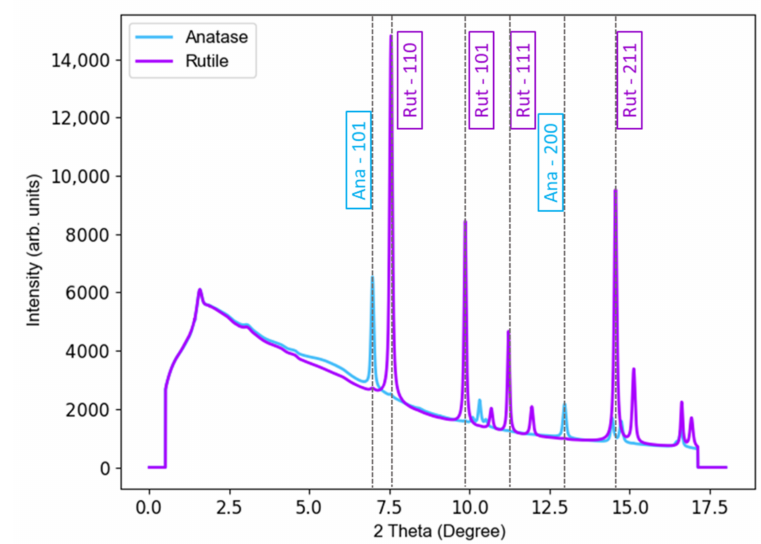
Figure A1. XRD spectra of pure anatase and rutile crystal phases. Distribution of µ XANES obtained from all sites, seasons and sizes.